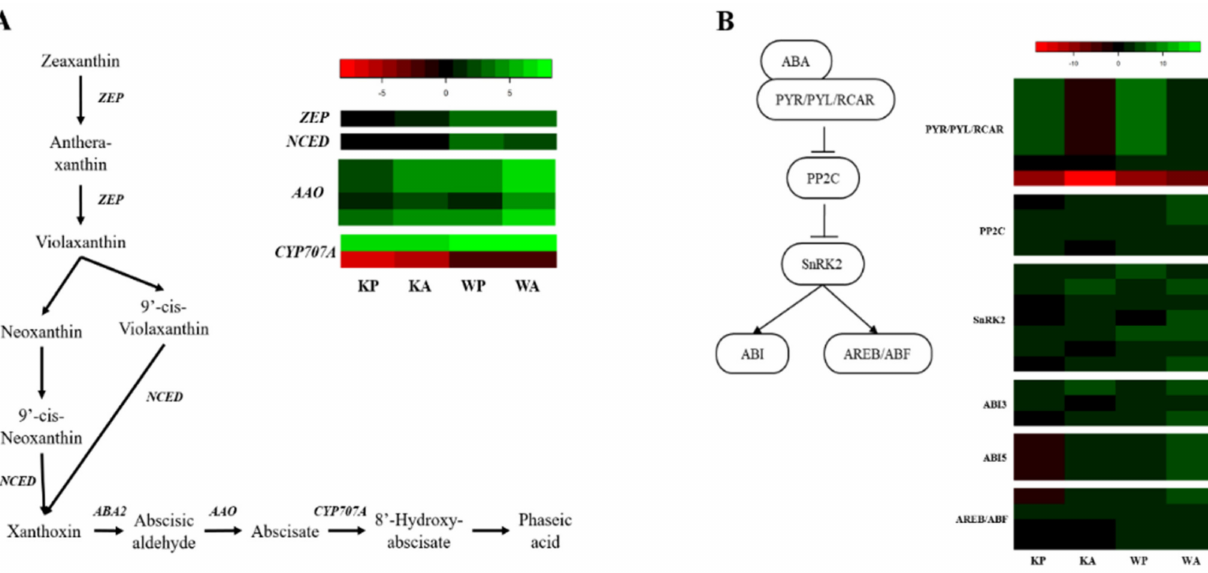
Figure 2. Heat map analysis of DEGs from preharvest sprouting (PHS) and Abscisic Acid (ABA) treatment for ABA hormone metabolism and signaling: ( A ) hormone metabolism pathway of ABA and comparative expression of genes related to ABA hormone metabolism and signaling pathway of ABA; ( B ) comparative expression of genes related to ABA signaling. The heatmap shows an expression change compared to the controls for each cultivar, with log2 fold-change